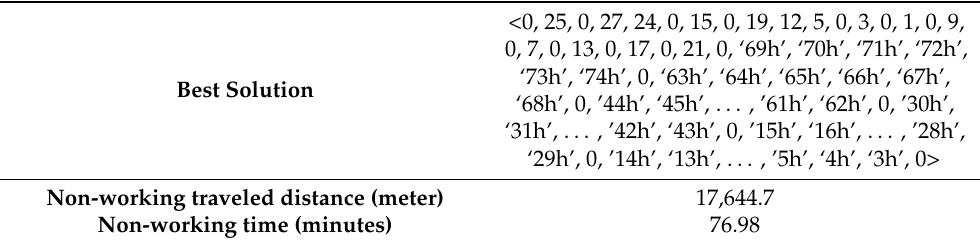
Table 2. Best solution for the sample field 1, capacity 24 m 3 (Optimized plan).